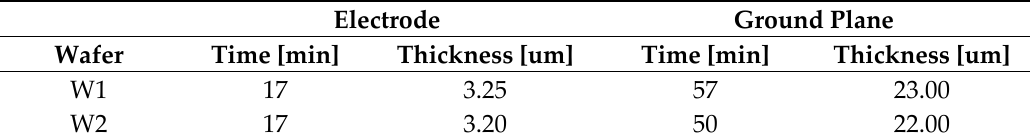
Table 2. Relation between the electrodeposition time and the thickness achieved